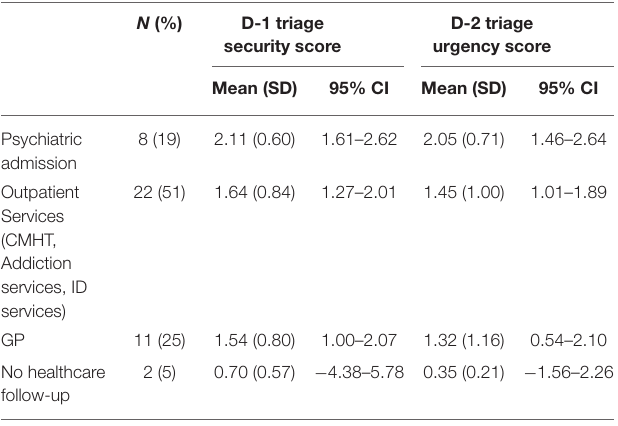
TABLE 4 | Risk-appropriateness of mental health outcomes for all those seen by PReP Programme ( N =